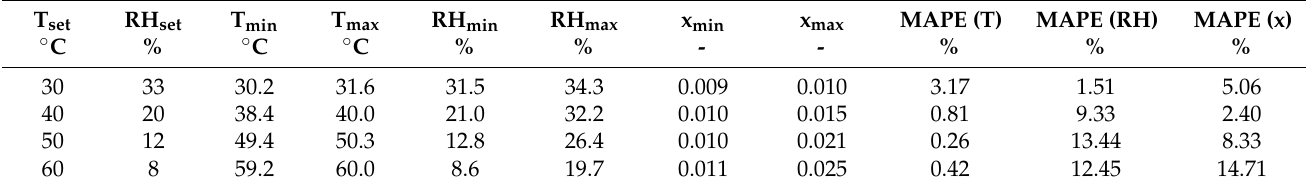
Table 4. Parameters during drying of fresh nettles at different temperatures in the HPD TP3+.